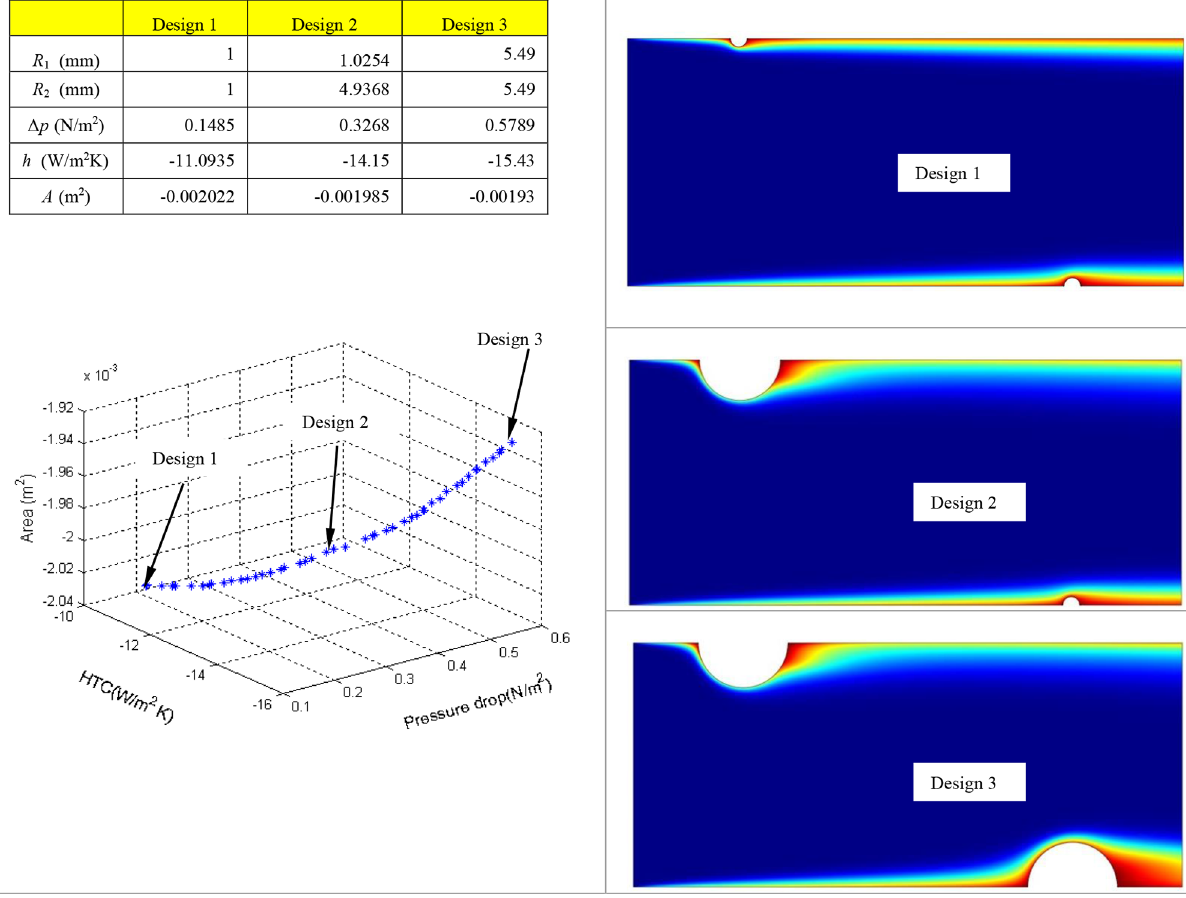
Fig. 11. Illustration of the design of cooling passage for 3 distinct optimal solutions.